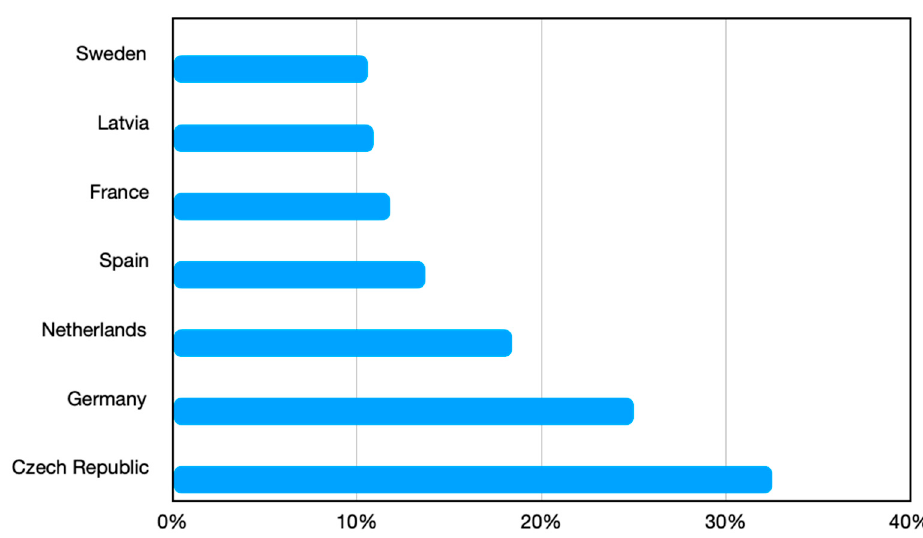
Figure 6. Gender pay gap in tech industry in the EU. Source: honeypot.com, accessed on 9 September 2021